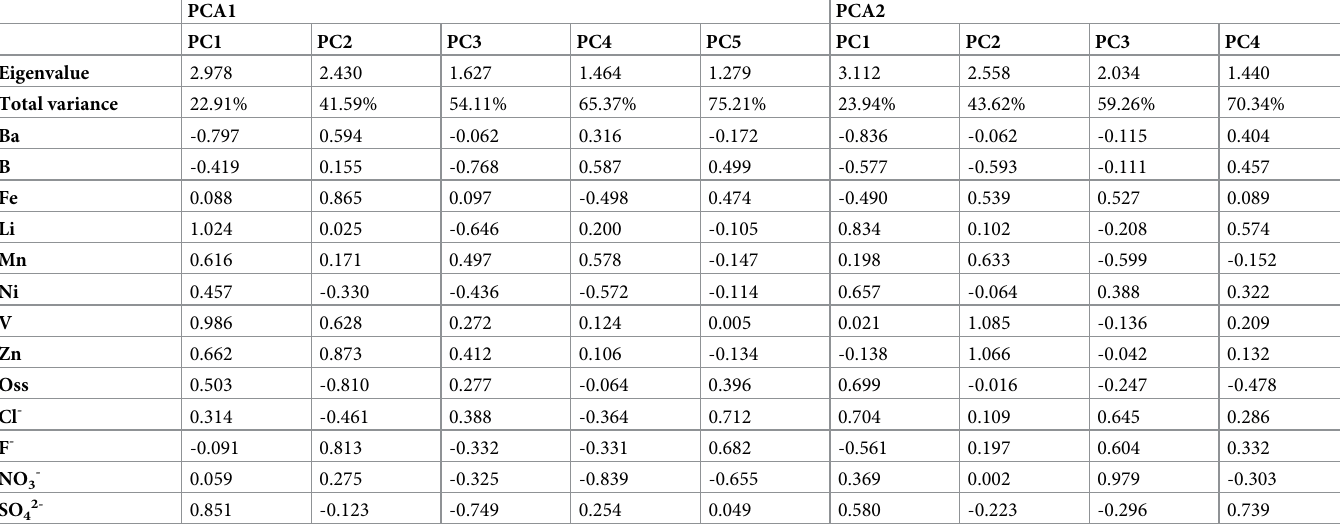
Table 2. PCA eigenvalues, total variance, and factor loadings of PCA1 and